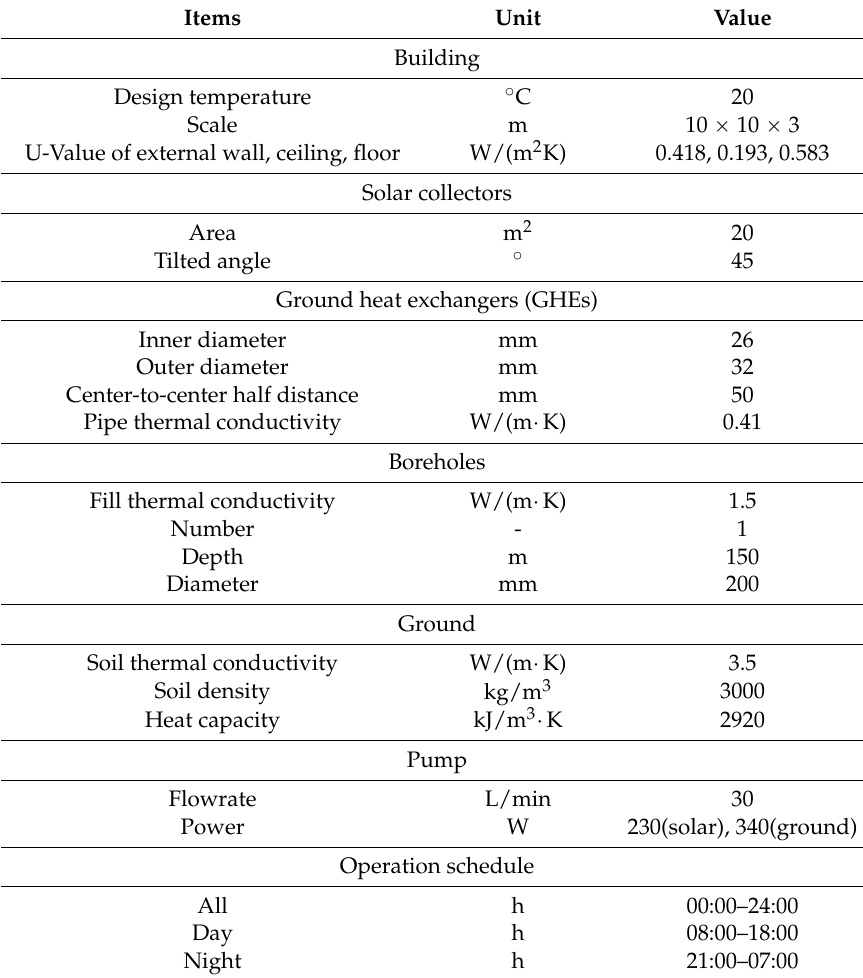
Table 1. Basic parameters of